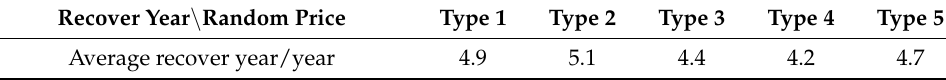
Table 12. Average recover year based on random electricity prices. Recover Year \ Random